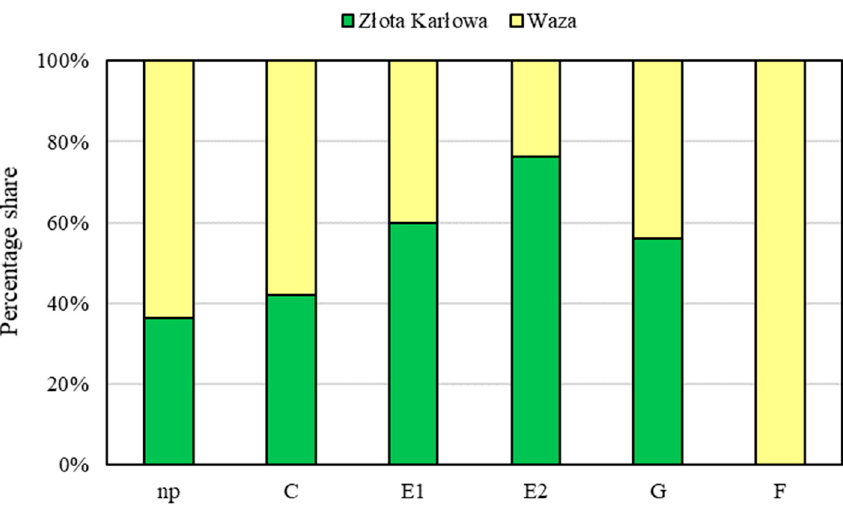
Figure 7. Percentage share of electrical penetration graph (EPG) models during M. dirhodum aphids’ feeding in the seedlings leaves of the tested maize cultivars (i.e., Waza and Złota Karłowa); np—non-